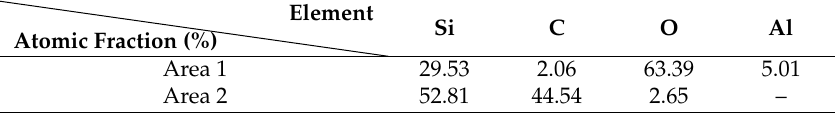
Table 2. Elemental analysis results of different regions in A3 displayed in Figure 4d.